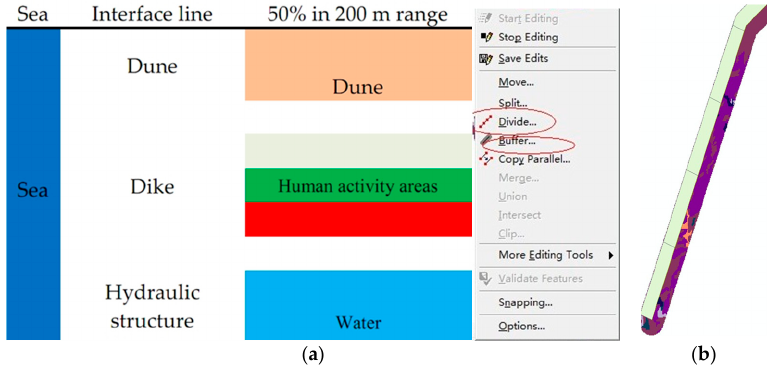
Figure 10. ( a ) Judgment of flood defense type for a shoreline system; ( b ) Buffer zone.